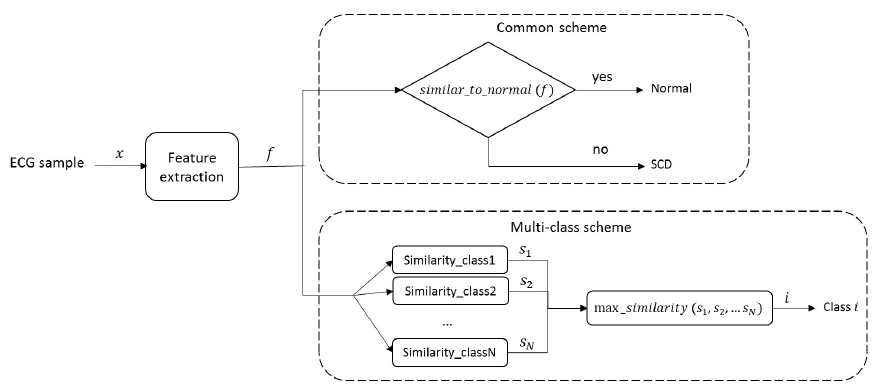
Figure 2. Proposed multi-class scheme and its comparison with the common scheme for SCD signal classification.